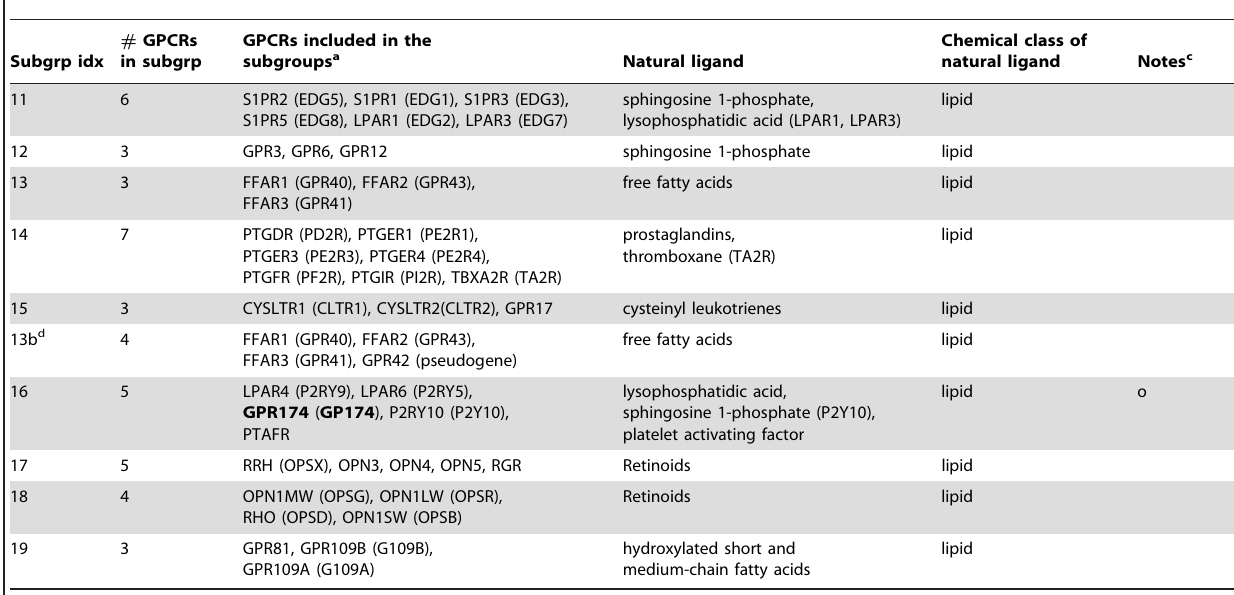
Table 2. List of class A GPCRs included in the study (continued from Table 1).